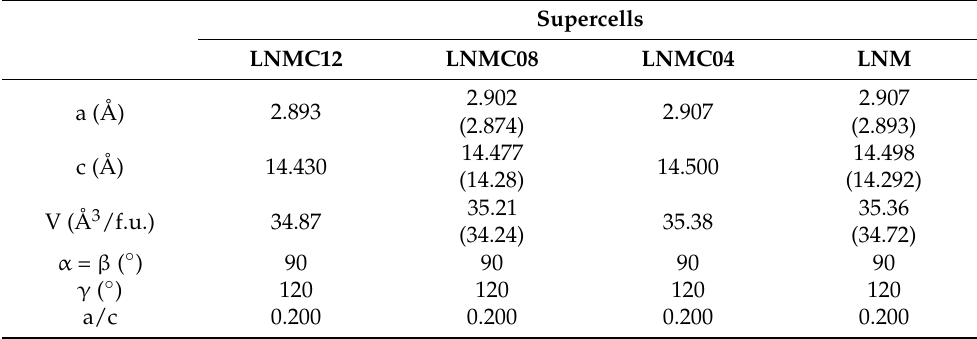
Table 1. Hexagonal hR12-reduced cell parameters of the optimized supercells. Available experimental literature values are reported in parentheses